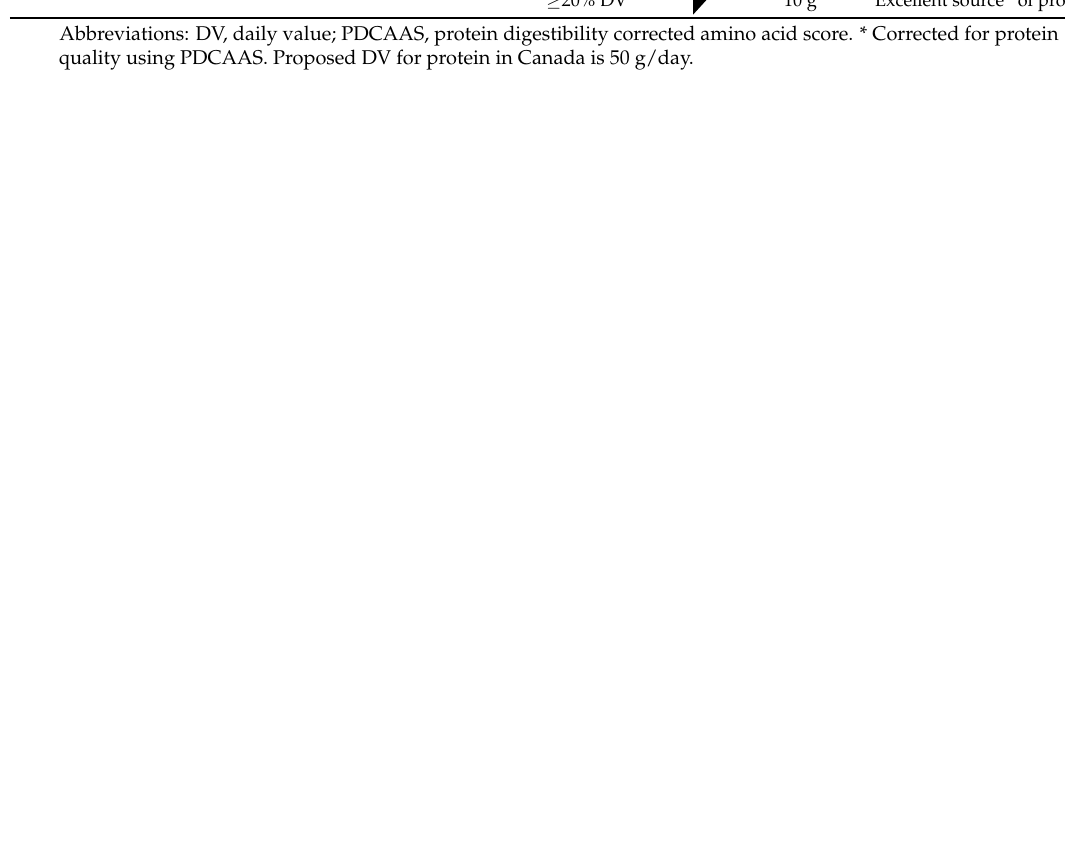
Table 3. Thresholds for protein content claims for proposed approaches to regulatory changes for protein content claims in Canada. Proposed Option 1: Removal of Protein Quality (Preferred)